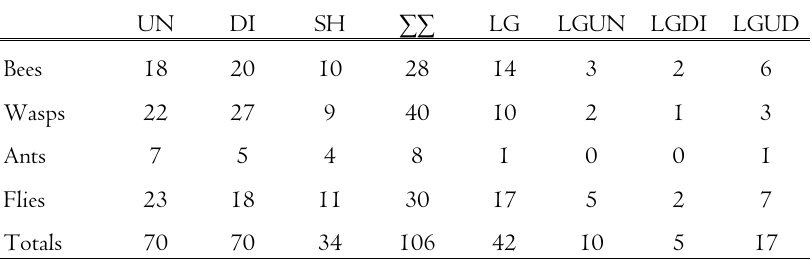
T ABLE 1. The number of bee, wasp, ant and fly species captured from the flowers of E. pelinophilum at the undisturbed (UN), disturbed (DI) and Lawhead Gulch (LG) sites. SH is the number of species shared between UN and DI, ∑∑ is the total number of unique species recorded in the study at UN and DI. LGUN is the number of species shared only between LG and UN, LGDI only between LG and DI, and LGUD at all three